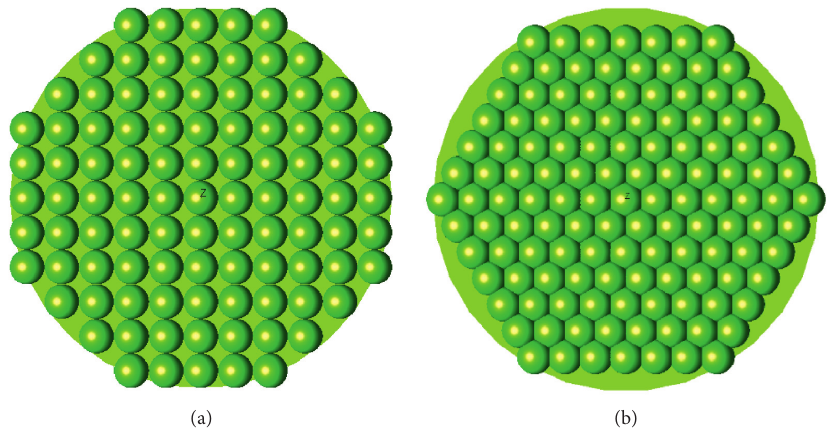
Figure 6: Array structure diagram of a compound eye plano-convex lens: (a) 97 monocular lenses with discrete distribution; (b) 127 monocular lenses with compact